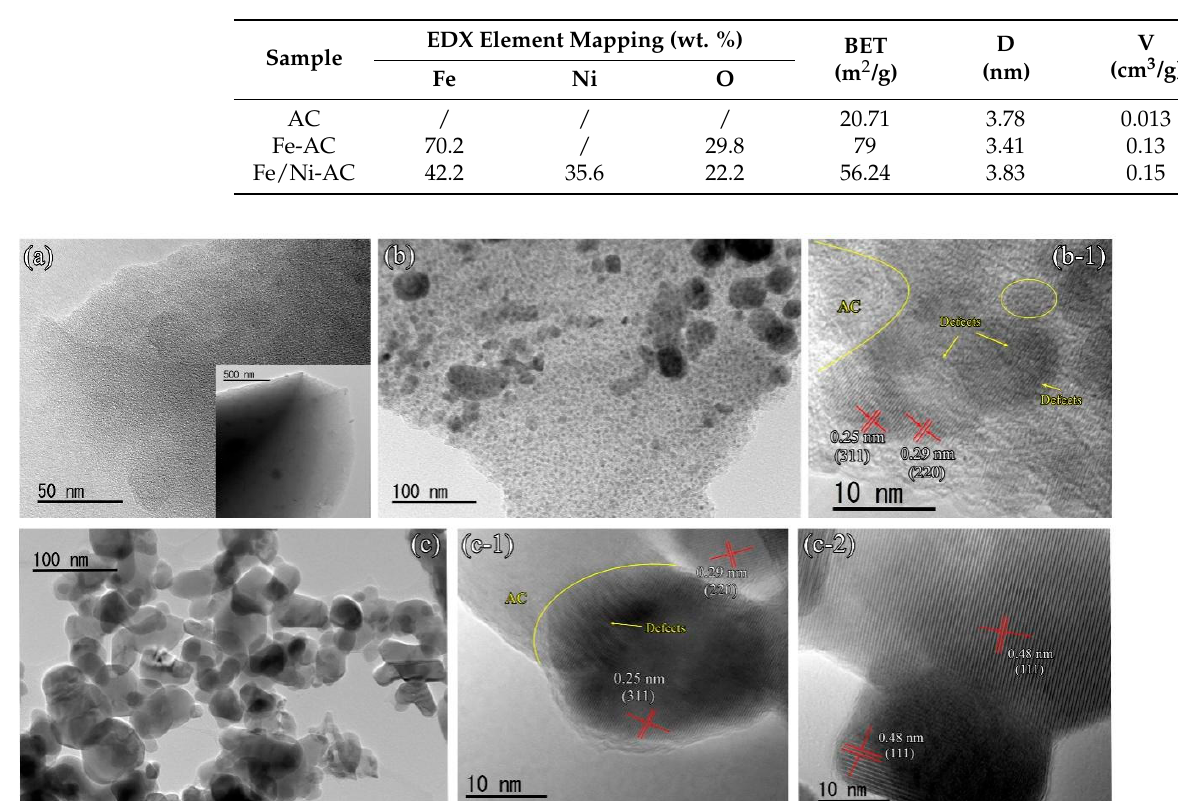
Figure 2. TEM and HRTEM images of ( a ) AC, ( b ) Fe-AC, and ( c ) Fe/Ni-AC. (Inset: the magnification of AC; ( b-1 , c-1 , c-2 ) are different magnification areas in Figure 2b,c, respectively.)